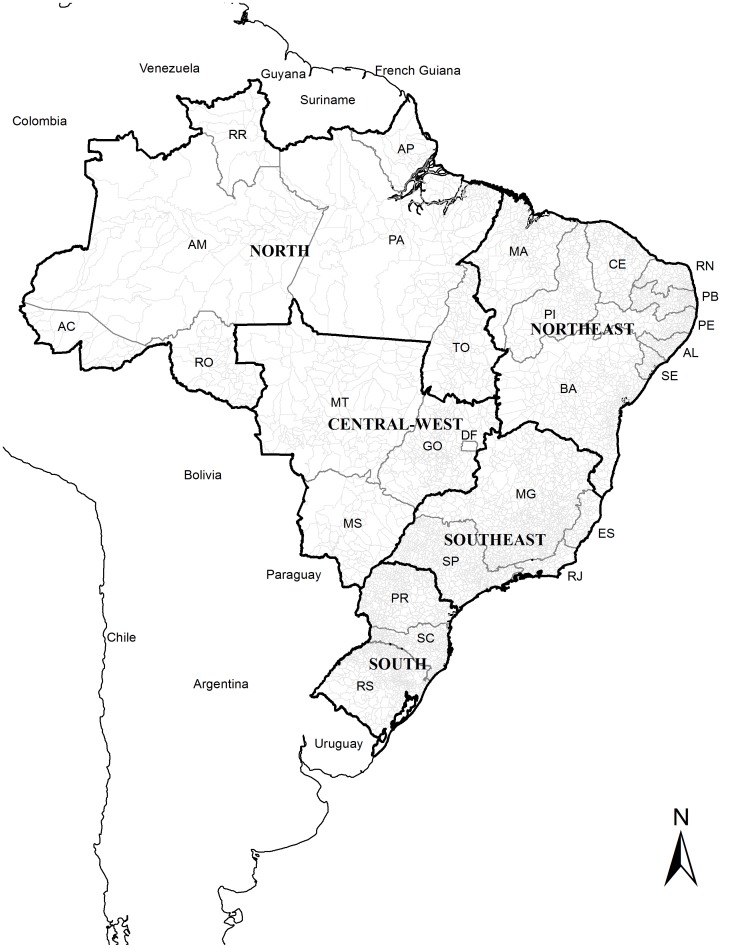
Brazil with its regions and 27 Federative Units.